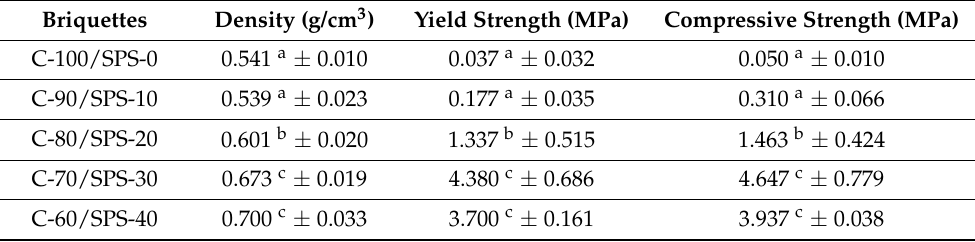
Table 5. Density and compressive strength of the char briquettes.